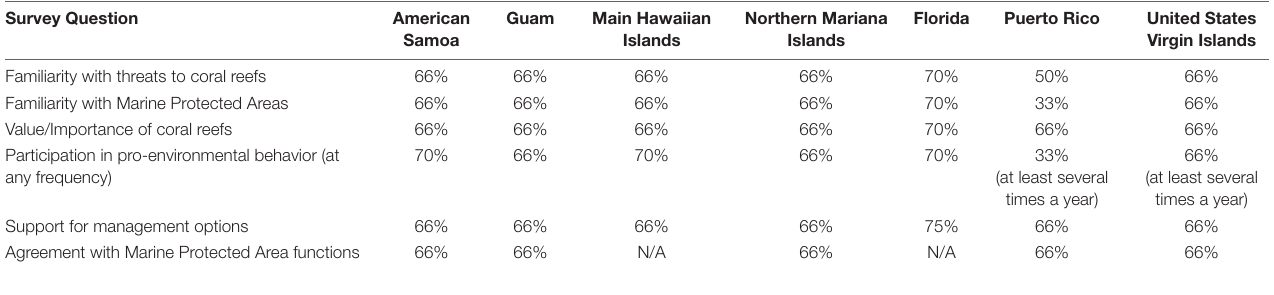
TABLE 6 | Summary of scoring thresholds for Human Connections indicators in the United States Pacific and Atlantic inhabited jurisdictions determined by expert opinion and professional judgment. Survey